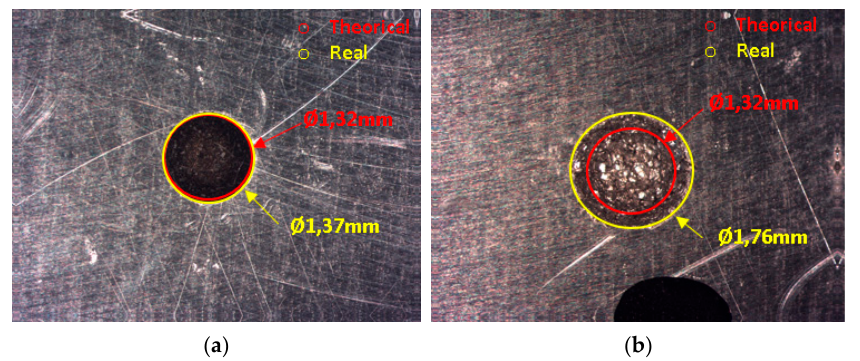
Figure 20. Geometrical comparison. ( a ) VDI 0 ( b ) VDI 27.